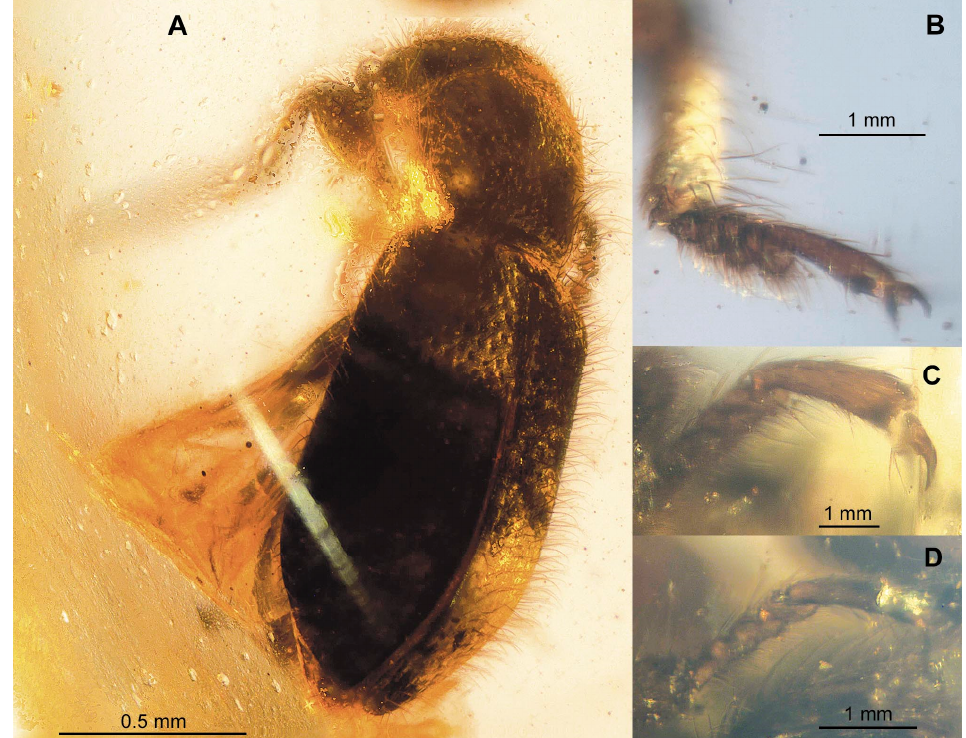
Figure 4. Pictures of Thanerosus antiquus gen. and sp. nov. holotype NIGP180154: ( A ) body of the holotype in a curved amber surface; ( B ) protarsi; ( C ) mesotarsi; ( D )